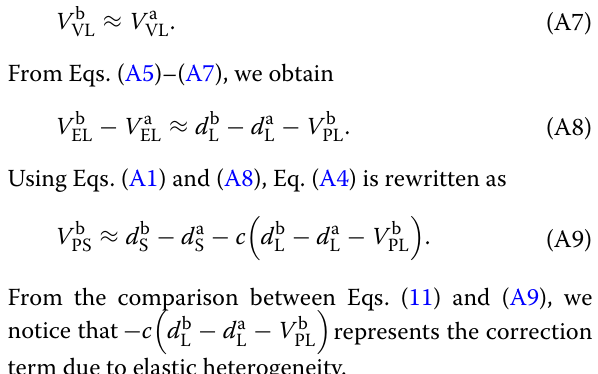
From Eqs. (A1) and (A13), we can obtain the upper and lower bounds of the correction term as